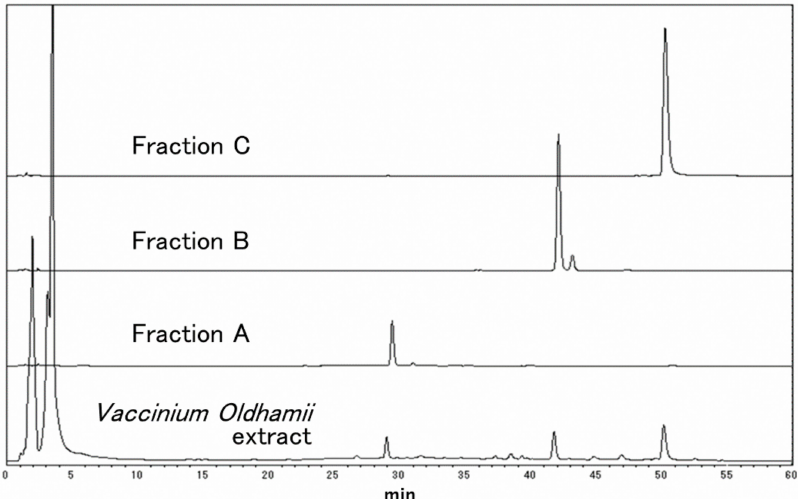
Figure 2. HPLC chromatograms for the Vaccinium oldhamii fractions separated by C18 column. Fractions A, B, and C were obtained from the fractions eluted with 30%, 40%, and 50% ethanol in Figure 1. Anthocyanin and chlorogenic acid were eluted in the earlier fractions, and they are not included in the three fractions (A to